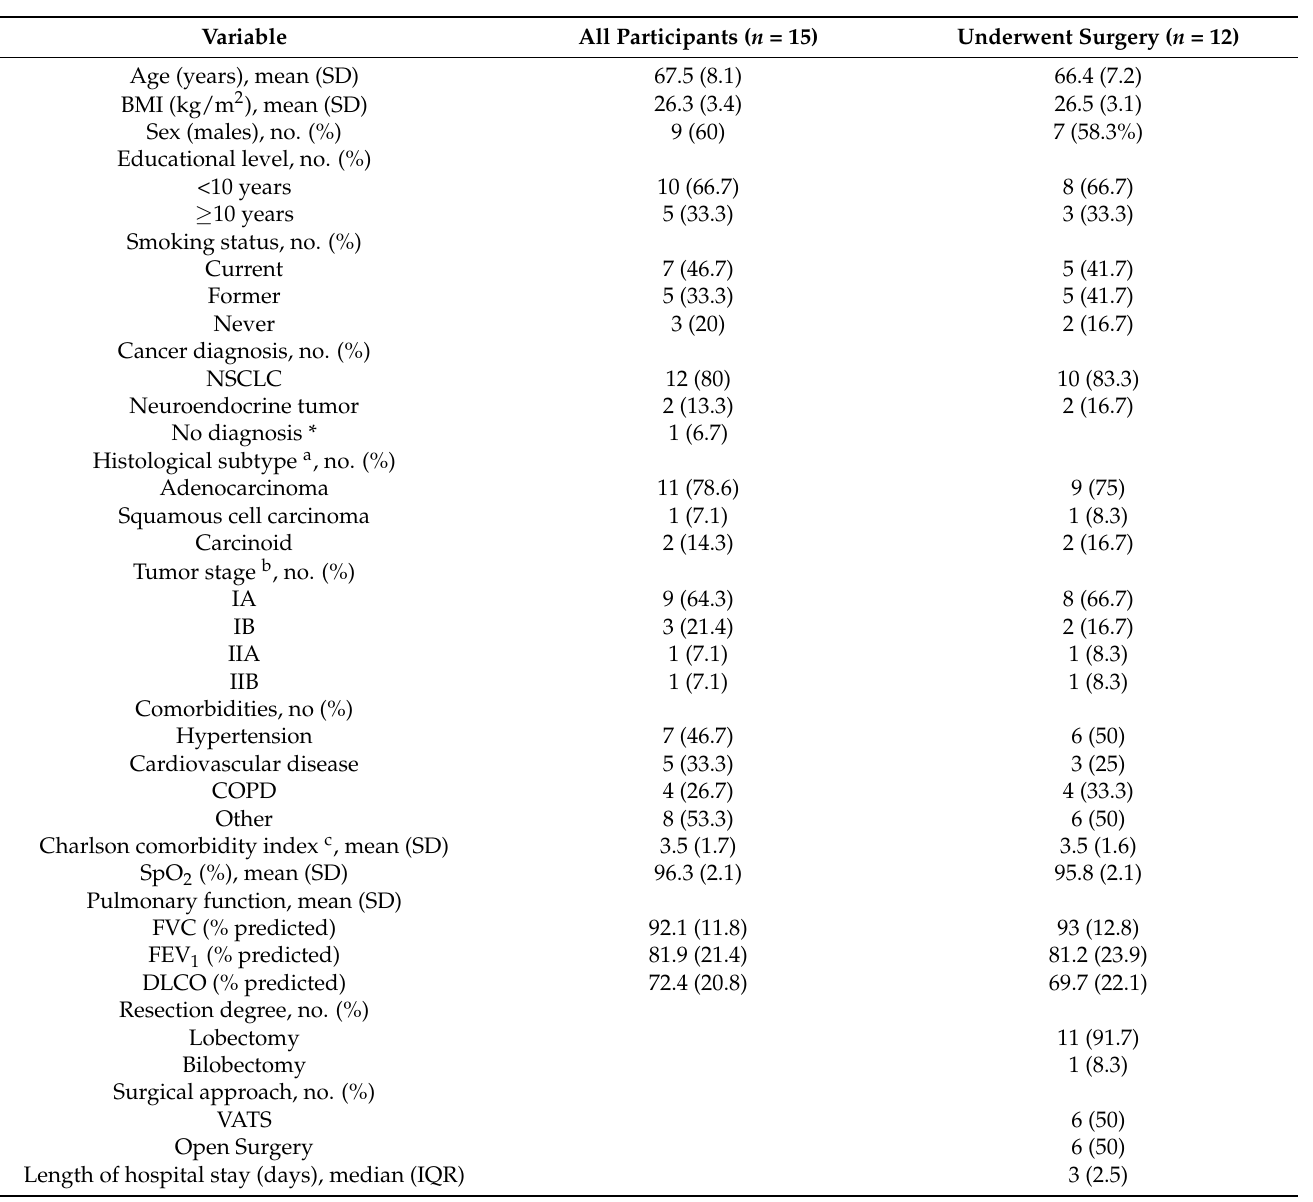
Table 1. Participant demographic and clinical